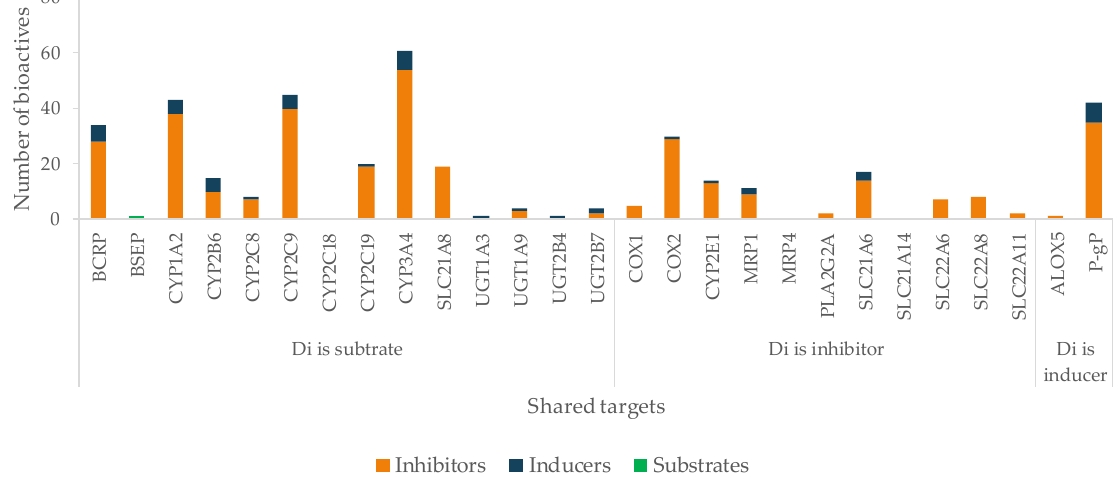
Figure 10. Number of bioactives affecting the shared targets with Di and respective mode of interaction (induction/inhibition). For clarity and due to relevance, bioactives were considered as substrates only for BSEP.